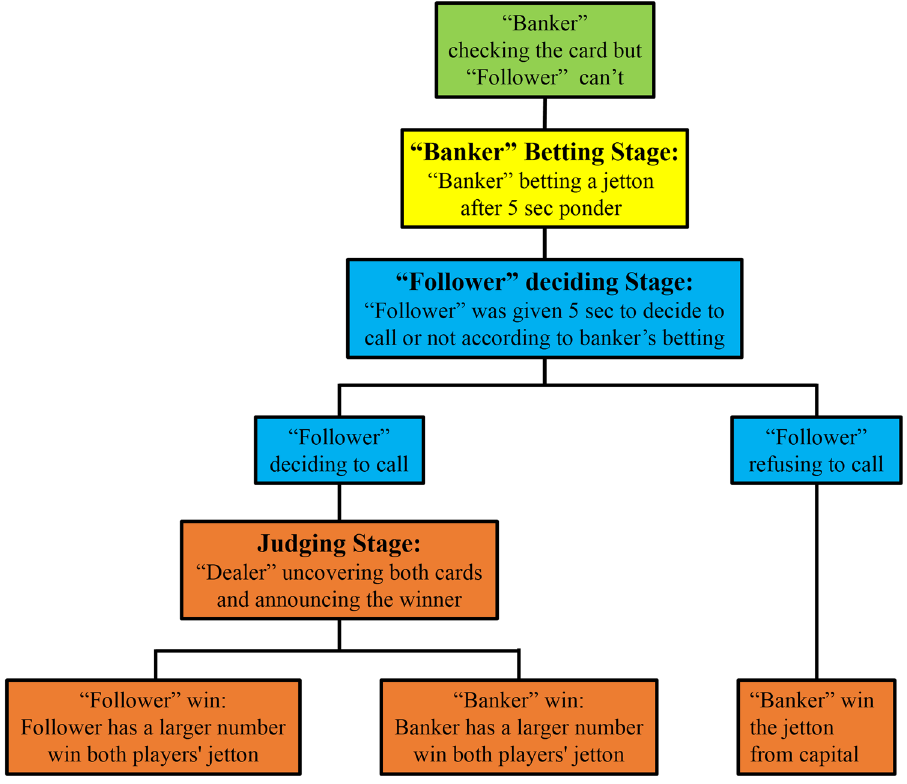
Figure 6. Procedure of each round of the card game. In each round, the dyads were randomly given one card per participant. The participant designated as the “banker” was then instructed to check his/her card and bet a jetton (1, 3, or 5 RMB) after 5 sec in which the banker could generate his/her decision. The other participant, the “follower,” was then given 5 sec to decide to call or not according to banker’s betting without checking his/ her own card. If the follower refused to call, the banker won the jetton. In contrast, if the follower decided to call, the dealer would uncover both cards and announced the winner (the participant whose card had a larger number won both players’ jetton). The dealer would then re-shuffle all five cards ending the round. The banker in the first round was chosen by a Finger Guessing Game, with banker-follower roles then alternating in every subsequent round. Participants were prohibited from discussing during the